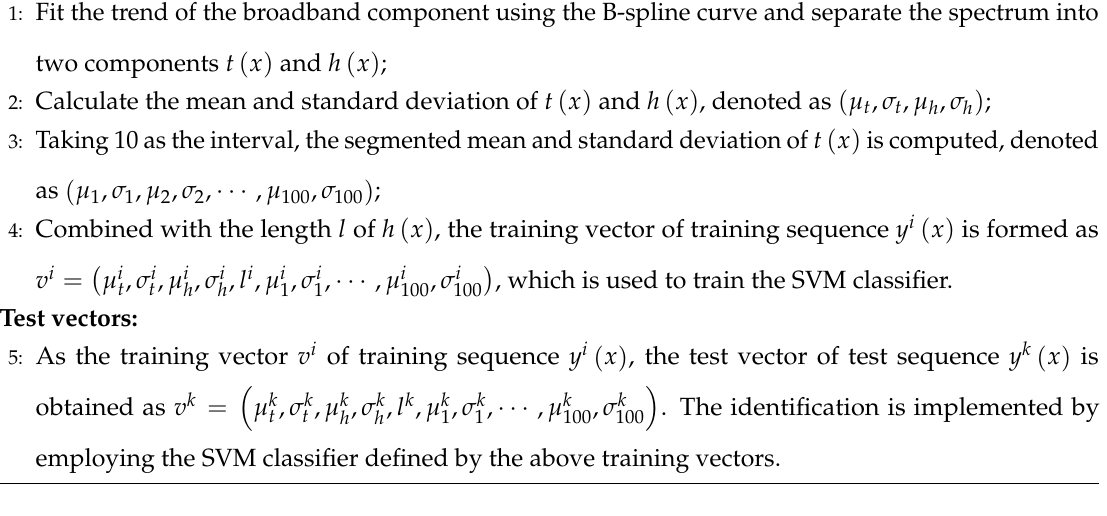
Algorithm 2 The extracting procedures for the training and the test vectors of the B-spline curve fitting-based